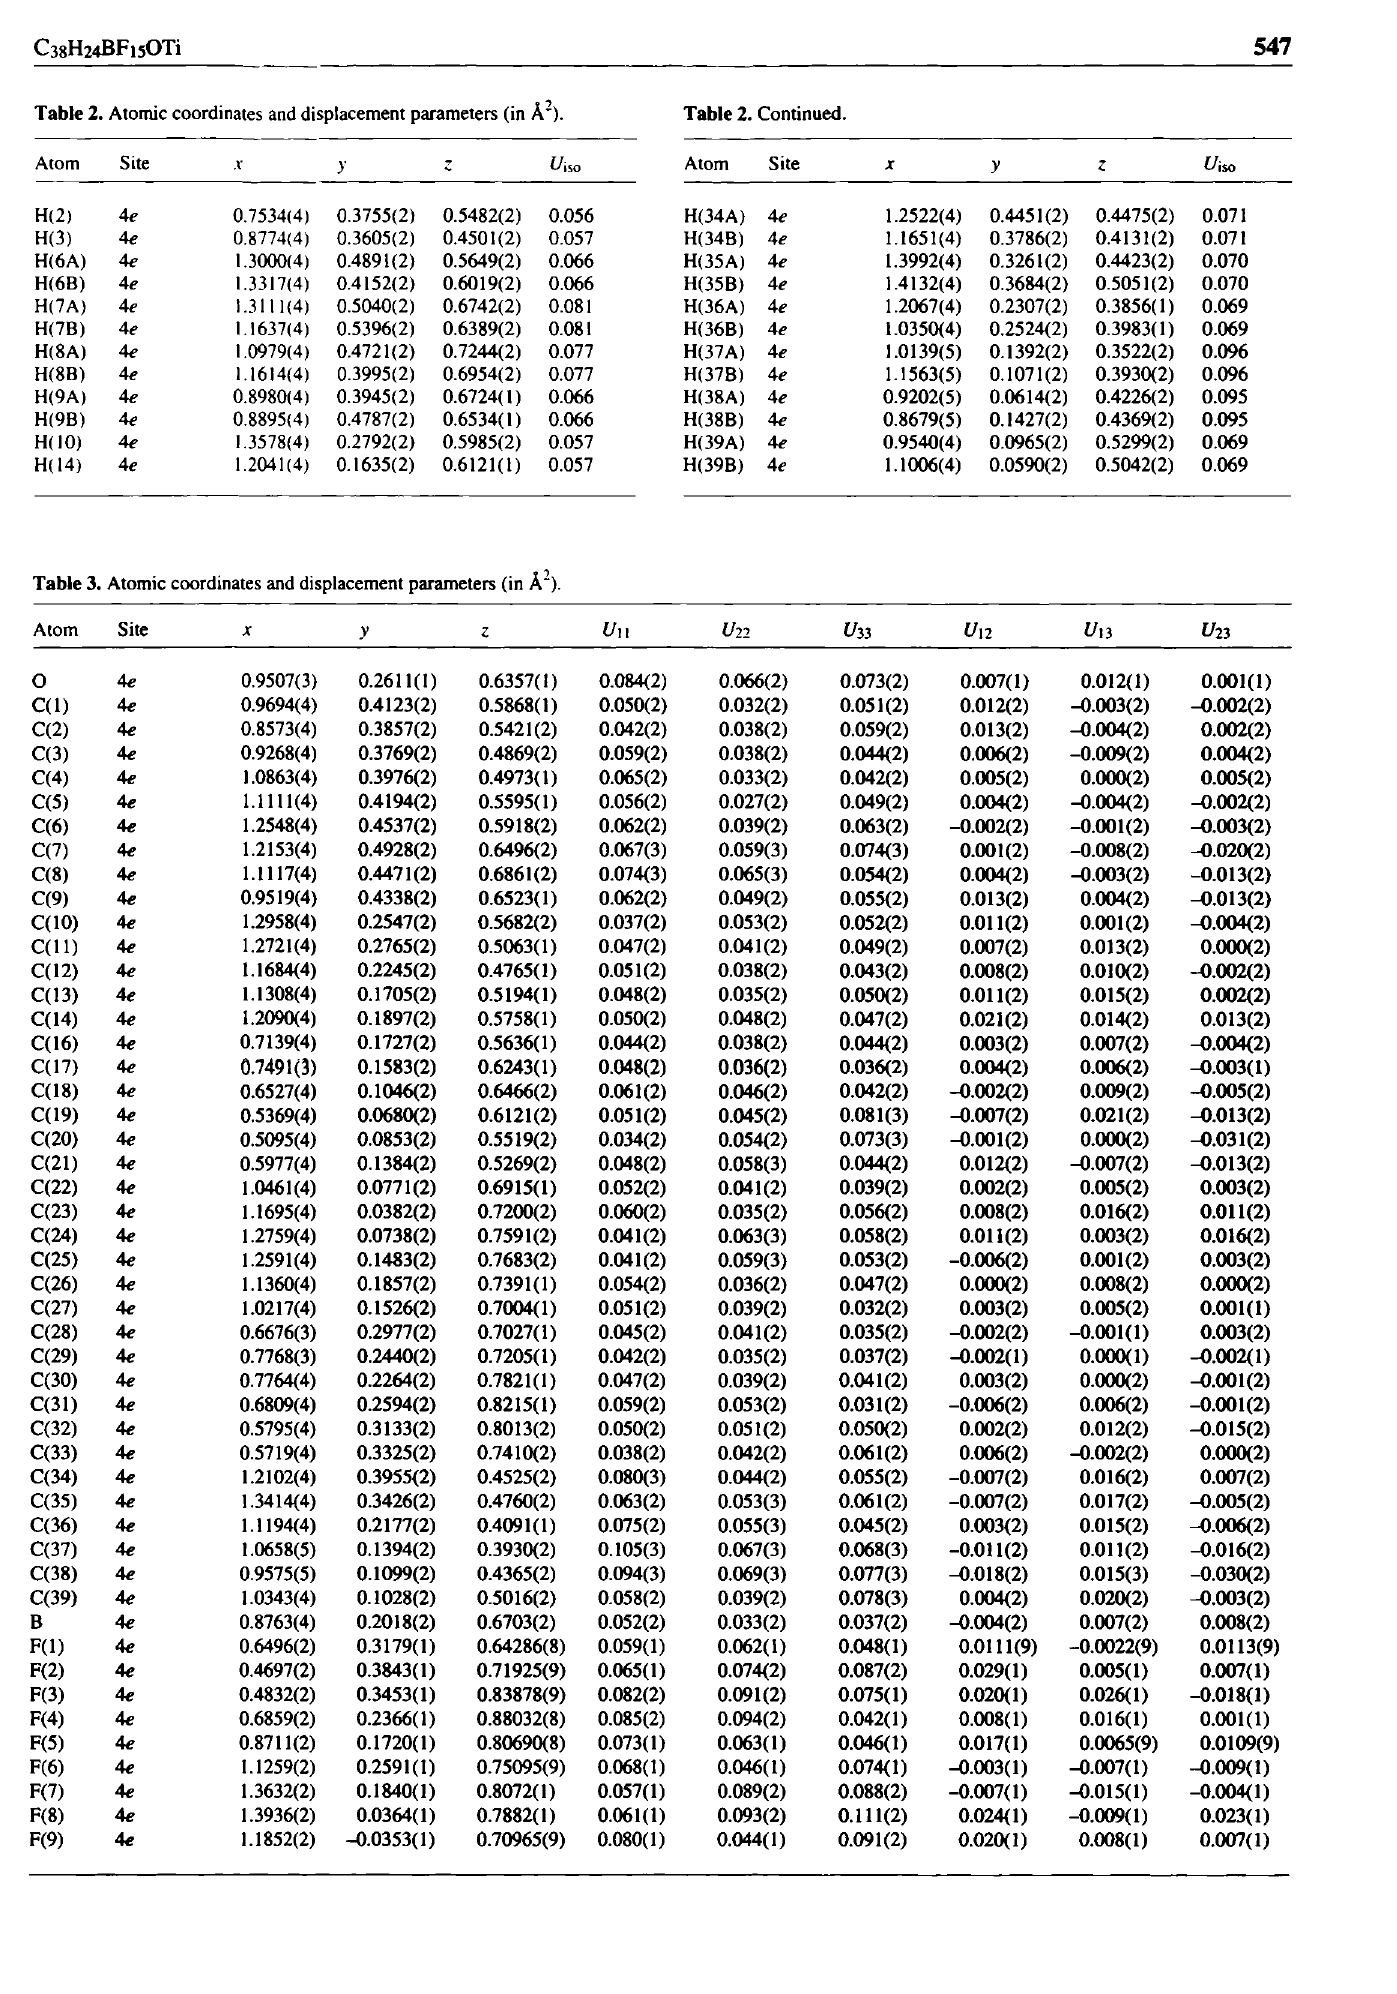
Table 2. Atomic coordinates and displacement parameters (in k~).